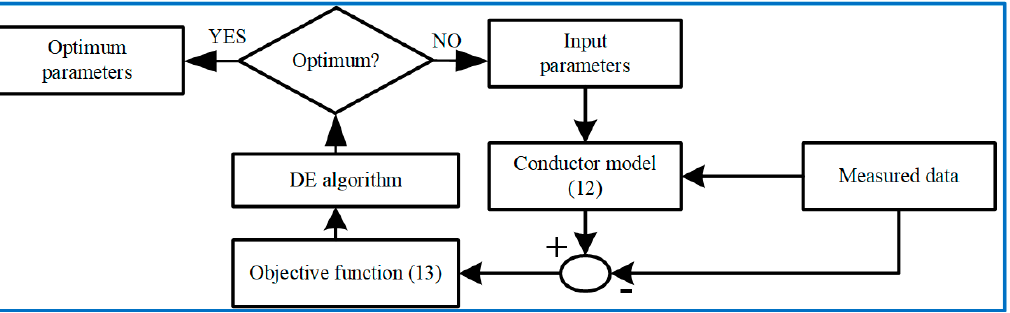
Figure 2. Schematic presentation of procedure for determining the parameters.